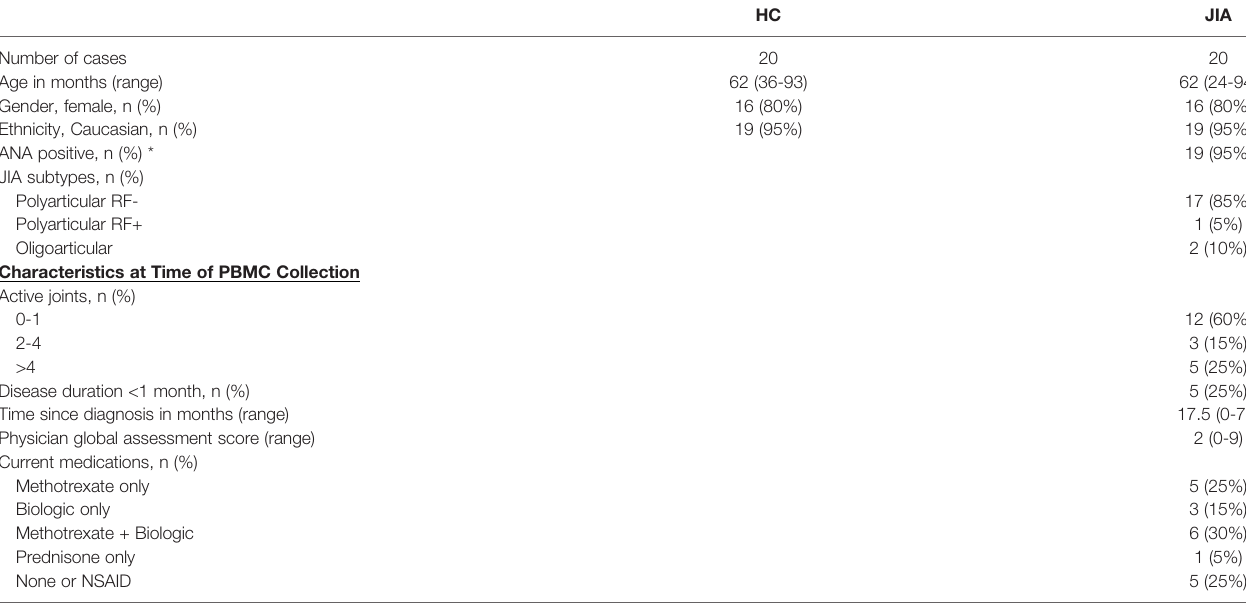
TABLE 1 | Demographic and clinical characteristics of JIA and child healthy control